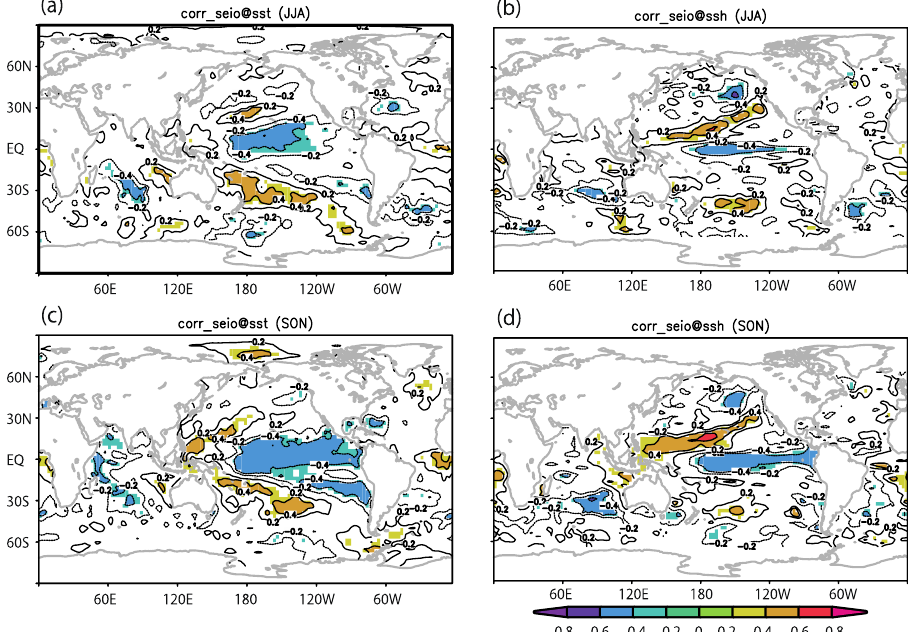
Figure 10. Same as Figure 9 but for the DJF observed TCF anomaly (defined as occurrence in 5° × 5° bins, units are TCs per season) over the SEIO region (averaged over 10 – 30° S, 90 – 120° E). ( a ) JJA SST,